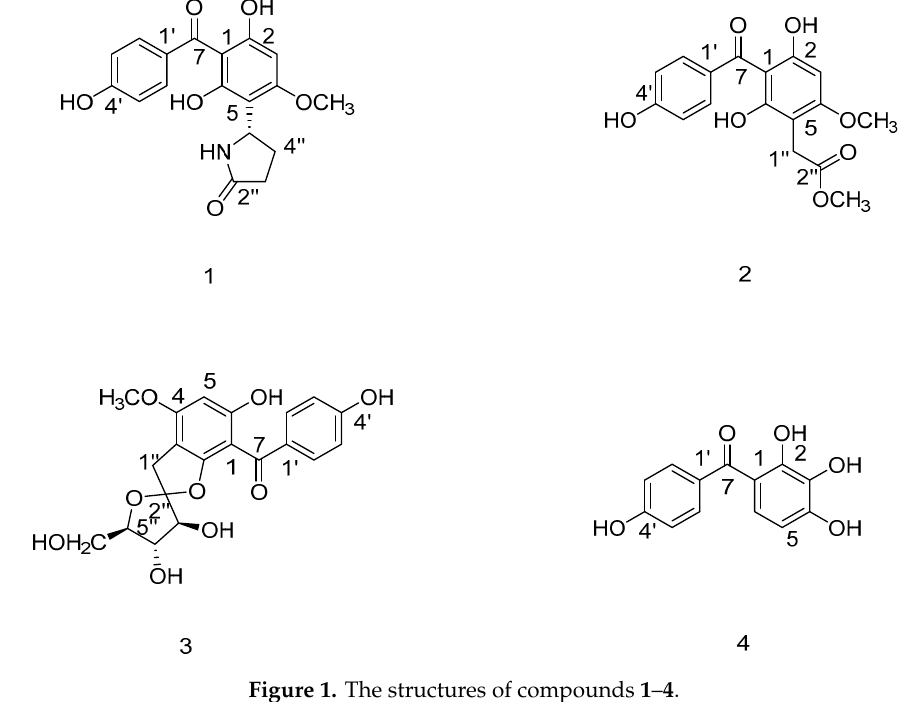
Figure 1. The structures of compounds 1 – 4 .